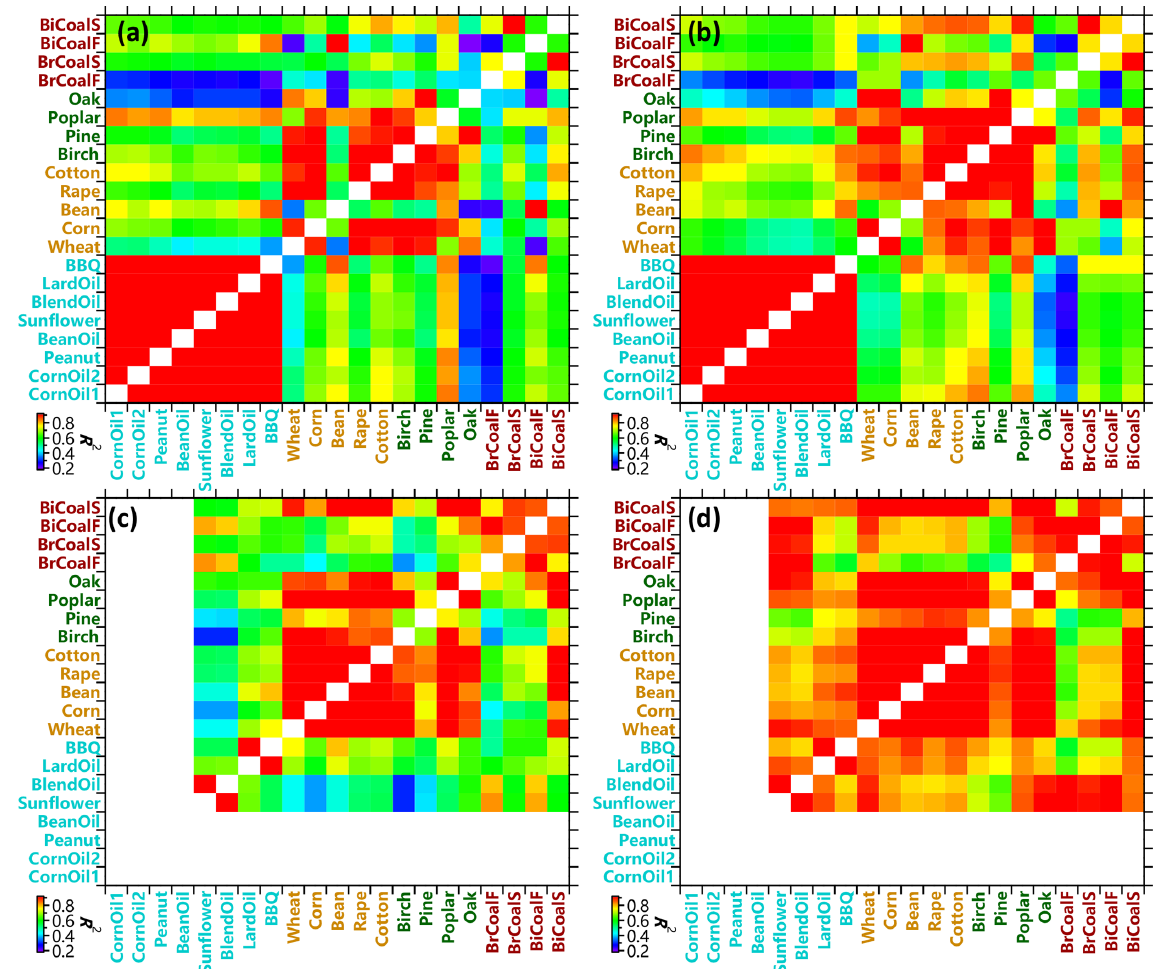
Figure 5. Mass spectral correlations of OA measured by (a) SV-AMS and (b) CV-ACSM and WSOA measured by (c) SV-AMS and (d) CV- ACSM. The detailed descriptions of cooking and burning fuels are presented in Table